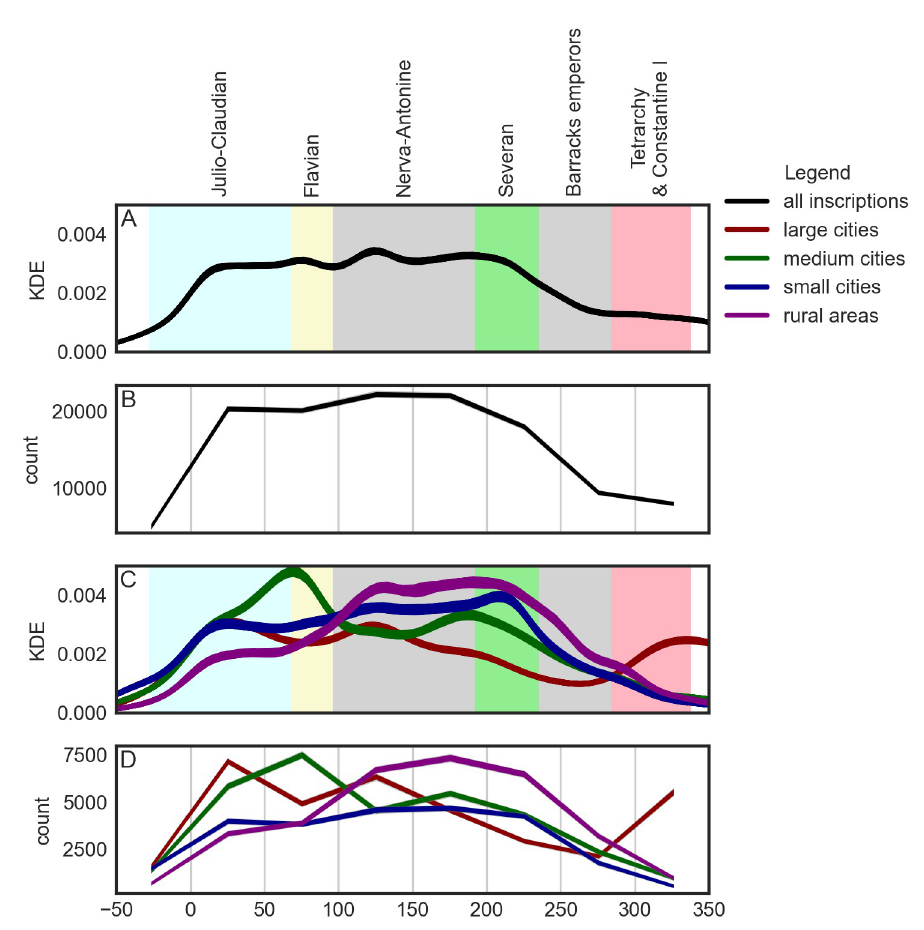
Fig 3. Temporal distribution of inscriptions by urban